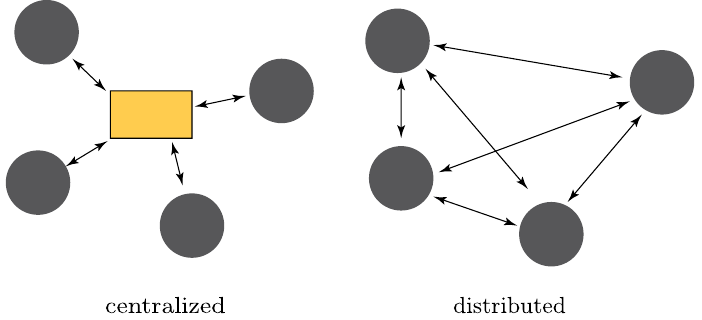
Figure 5. Centralized vs distributed cooperative positioning (CP)